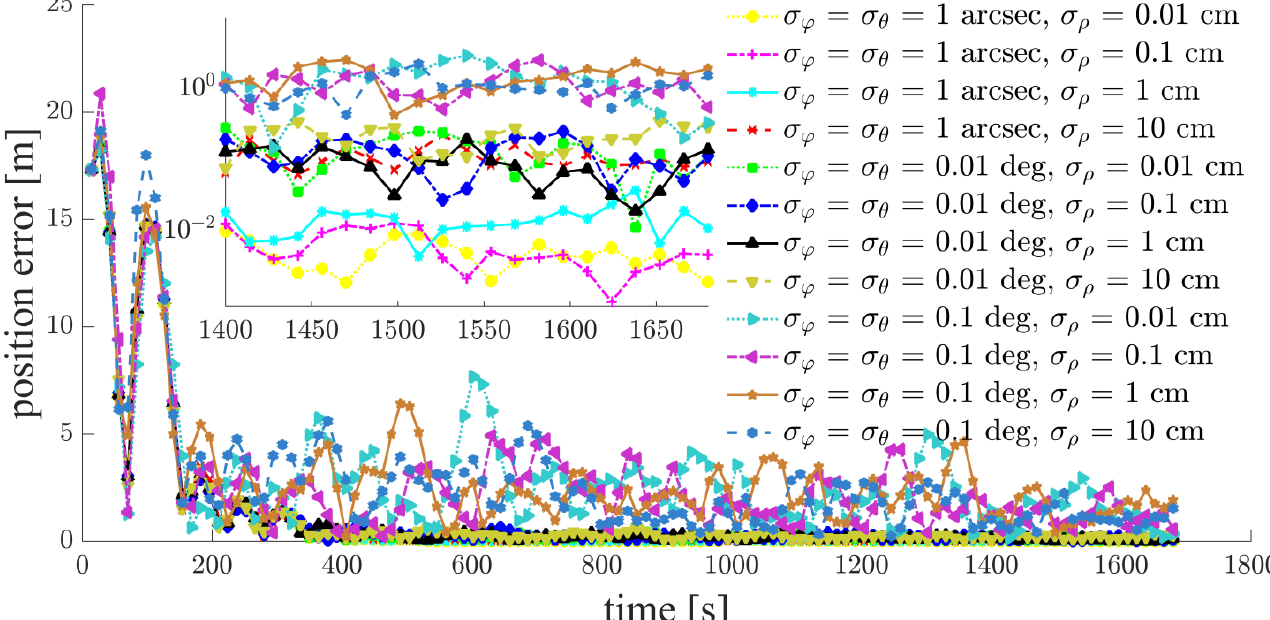
Sensors 2021 , 21 , x FOR PEER REVIEW Figure 14. Relative navigation errors of 𝑆 4 (simulated scenario: Case d, space-circle formation radius of 1 km). Figure 14. Relative navigation errors of S 4 (simulated scenario: Case d, space-circle formation radius of 1 km).